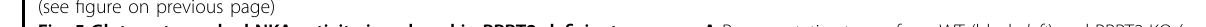
Fig. 5 Glutamate-evoked NKA activity is reduced in PRRT2-de fi cient neurons. A Representative traces from WT (black; left ) and PRRT2 KO (red; right) primary hippocampal neurons show the response to glutamate puffs performed under control conditions (ctrl) or under blockade of the NKA with 1 mM ouabain (oua). Black triangles show the time of the application of the glutamate puff (glu). Digital subtraction of the response obtained in the presence of ouabain from the control response yields the NKA activity (green traces). The integrated area under this ouabain-sensitive current (gray-shaded area) de fi nes the NKA charge. B – D NKA charge ( B ), glutamate puff-induced current ( C ), and NKA charge normalized by the amplitude of the glutamate current ( D ) for WT and PRRT2 KO primary neurons ( n = 29 and 28 neurons for WT and PRRT2 KO, respectively, from three independent neuronal preparations). E Primary hippocampal neurons were subjected to acute PRRT2 knockdown (KD) by RNA interference and to rescue of PRRT2 expression by transduction with a Sh-resistant PRRT2 construct. Representative traces recorded from neurons 7 days post-infection with Scramble/Control Cherry (Scr; black; left ) or Sh4/Control Cherry (KD; red; middle ) or Sh4/PRRT2-Cherry (KD + PRRT2; blue; right ) upon glutamate puffs performed in the absence (ctrl) or presence of 1 mM ouabain (oua). Black triangles mark the time of glutamate application. Green traces indicate the NKA activity. F – H NKA charge ( F ), glutamate puff-induced current ( G ) and NKA charge normalized by the amplitude of the glutamate current ( H ) for Scr, PRRT2 KD, and KD + PRRT2 neurons ( n = 52, 61, and 46 neurons for Scr, PRRT2 KD and KD + PRRT2, respectively, from six independent neuronal preparations). Bar plots show the means ± SEM with superimposed individual experimental points. * p < 0.05, ** p < 0.01, *** p < 0.001; one- way ANOVA/Bonferroni ’ s